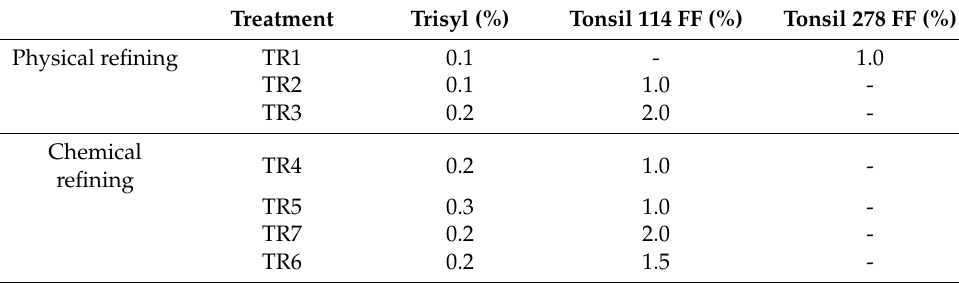
Table 1. Proportions of agents used in the different bleaching